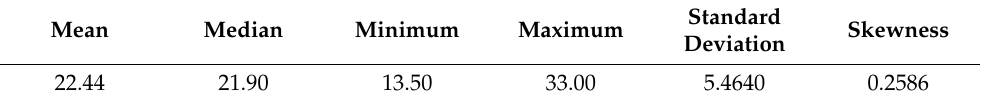
Table 3. Descriptive statistics of annual quantity of foraged mushrooms (1994–2021).